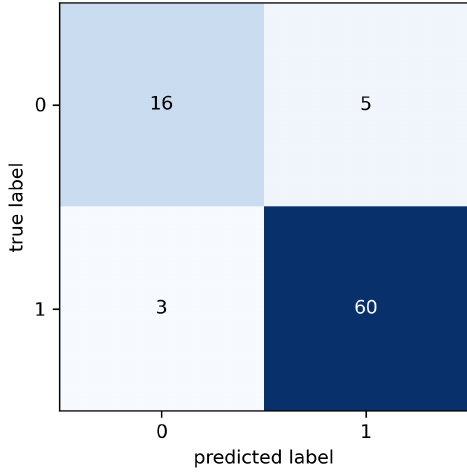
Figure 16. Decision tree confusion matrix.